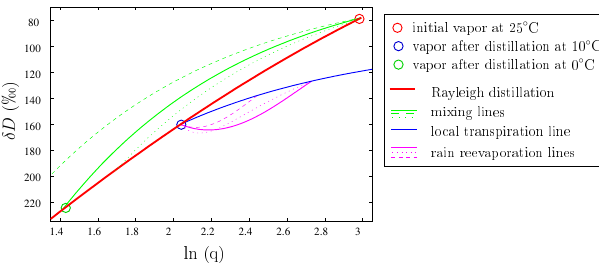
Figure 1. Theoretical lines in the δD - q plot. The initial vapor (red circle) is assumed to be formed over ocean, with a surface tem- perature of 25 ◦ C and surface relative humidity of 70% according to the Merlivat and Jouzel (1979) closure assumption. This vapor follows a Rayleigh distillation following equation 1 (red line). The green lines show mixing lines between the initial vapor and a vapors distilled down to different temperatures: 0 ◦ C (thick line), − 5 ◦ C (dashed line) and 5 ◦ C (dotted line). These lines are similar to those in Worden et al. (2007). The blue and magenta lines show mixing lines between vapor distilled down to 10 ◦ C and the re-evaporation of rain. We assume that the rain is in equilibrium with the overly- ing vapor. The blue line represents the evaporation of rain without any fractionation, as is the case for transpiration of soil water. The magenta lines represents the evaporation of rain with fractionation, following Stewart (1975) and Bony et al. (2008): re-evaporation of rain in an equal amount of water vapor with air humidity of 70% (solid), in an equal amount of water vapor with 90% humidity (dot- ted) or in a twice larger amount of water vapor with 70% humid- ity (dashed). Note that these re-evaporation lines are different from those in Worden et al. (2007), because they neglected the evolution of the raindrop composition during re-evaporation, whereas we do a more precise calculation, and because they plotted a combination of distillation and re-evaporation, whereas we plotted the effect of re-evaporation